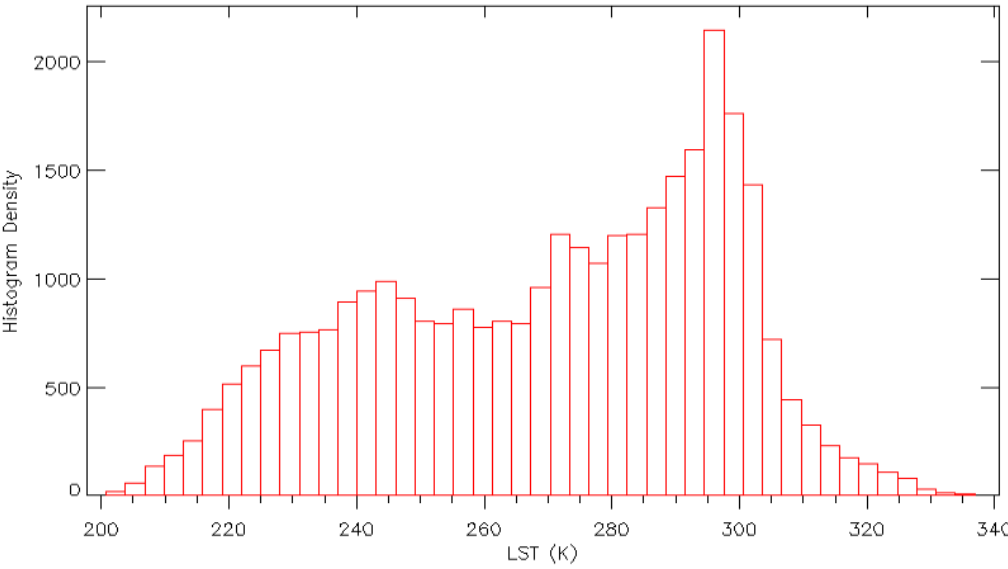
Figure 2. Histogram showing the distribution of LSTs in the selection database (2013). The large cool section corresponds to the Antarctic Regions.